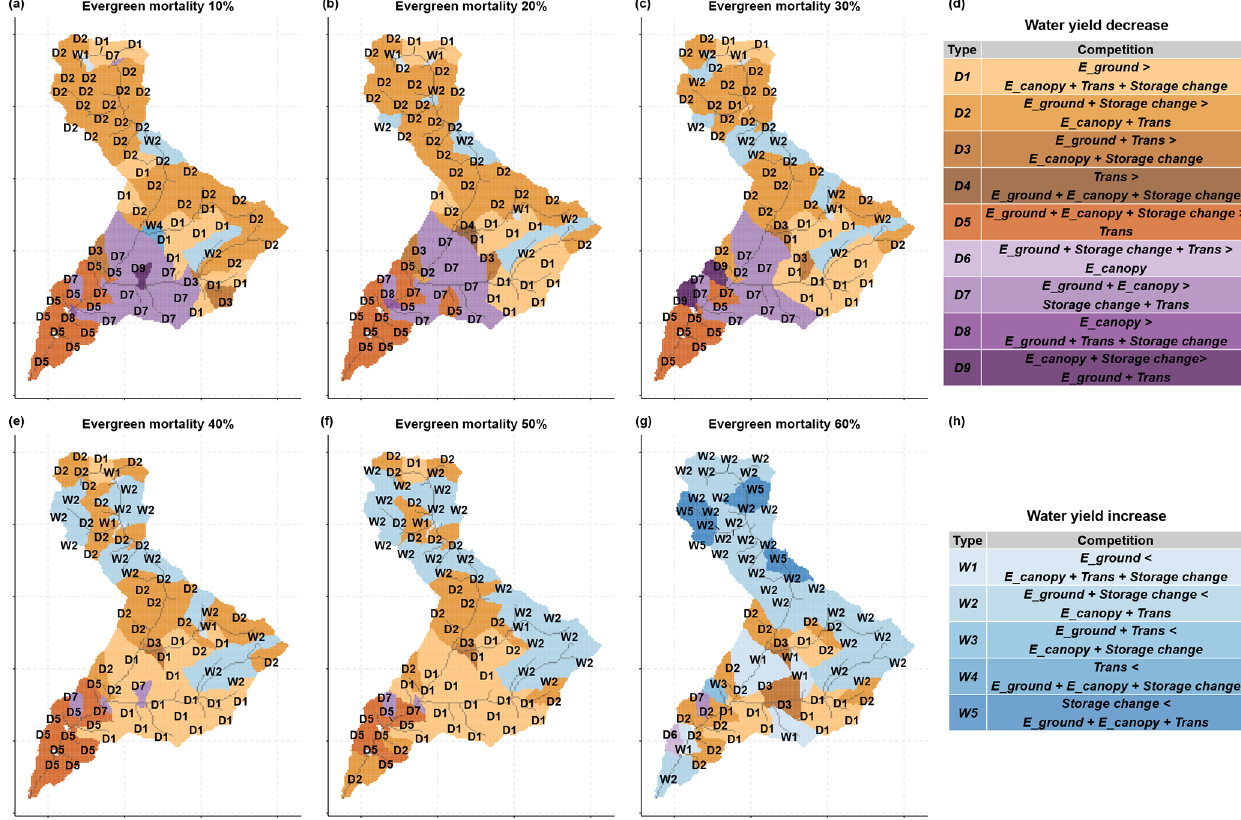
Figure 11. Water yield response types after the beetle outbreak for different evergreen mortality scenarios compared with the control scenario. D1–D9 are water yield decrease types and W1–W5 are water yield increase types. In panels (d) and (h) , the left side of each type are increasing fluxes that cause water yield decreases, and the right side of each type are decreasing fluxes that cause water yield increases. If the left side is larger than the right side, the water yield increases, and vice versa. (Note: this mortality is evergreen mortality, which is different from vegetation